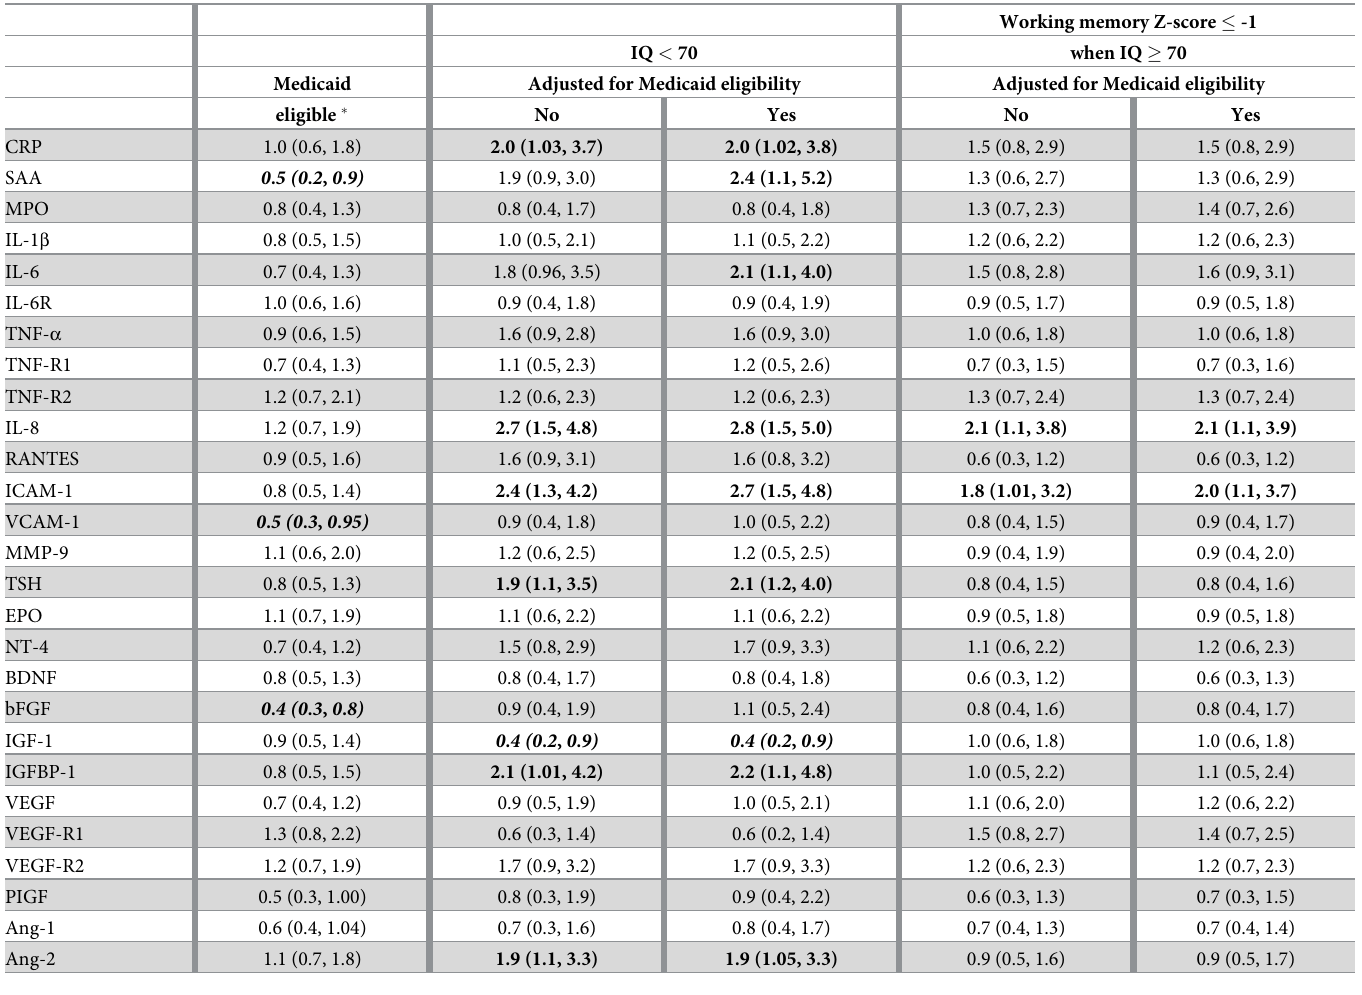
Table 5. Odds ratios (95% confidence intervals) for the 10-year old having an IQ less than 70, and separately, among children whose IQ � 70, having a working memory more than one standard deviation below the expected mean associated with a top-quartile concentration of the protein listed on the left on 2 days during the late epoch. In one set of analyses adjustment is made for mother’s Medicaid eligibility at the time of delivery, while in another, such adjustment is not made although in both situations adjustment is made for gestational age category and birth weight Z-score < -1. Bold indicates odds ratios significantly > 1 (p < 0.05) and bold italic indi- cates odds ratios significantly < 1 (p <